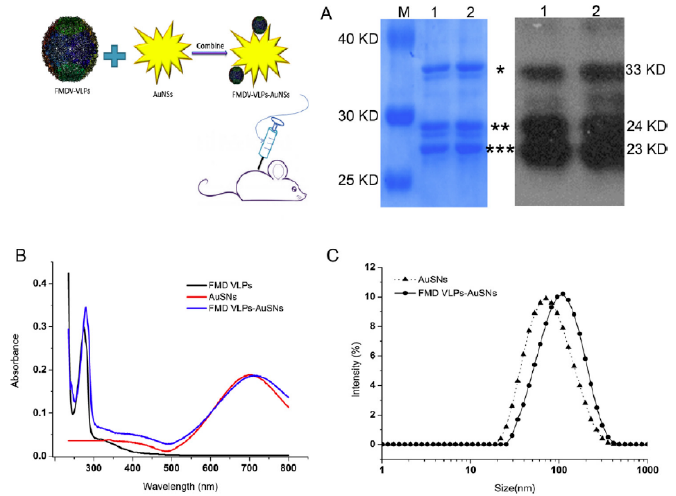
Figure 9. A ) Schematic of the preparation of foot-and-mouth disease virus-like particle gold nanostars (FMD VLPs-AuSNs) complex. SDS page and western blot analysis FMD VLPs and FMD VLPs-AuSNs complexes; B ) Fluorescent absorbance of the nanocomplex. C ) Size distribution. Reproduced with